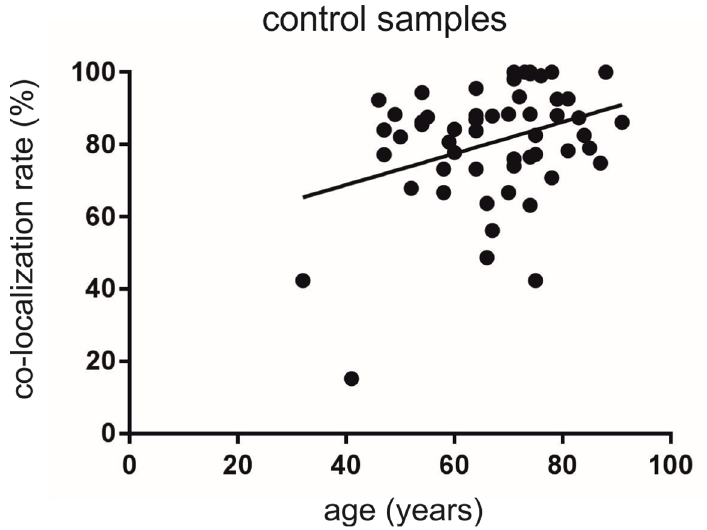
Figure 3. Analysis of the co-localization rates of TH-ir neurons also expressing Nogo-A depending on the age in the human SNc from non-diseased individuals. We found a significantly higher co-localization rate with increasing age ( p < 0.05).